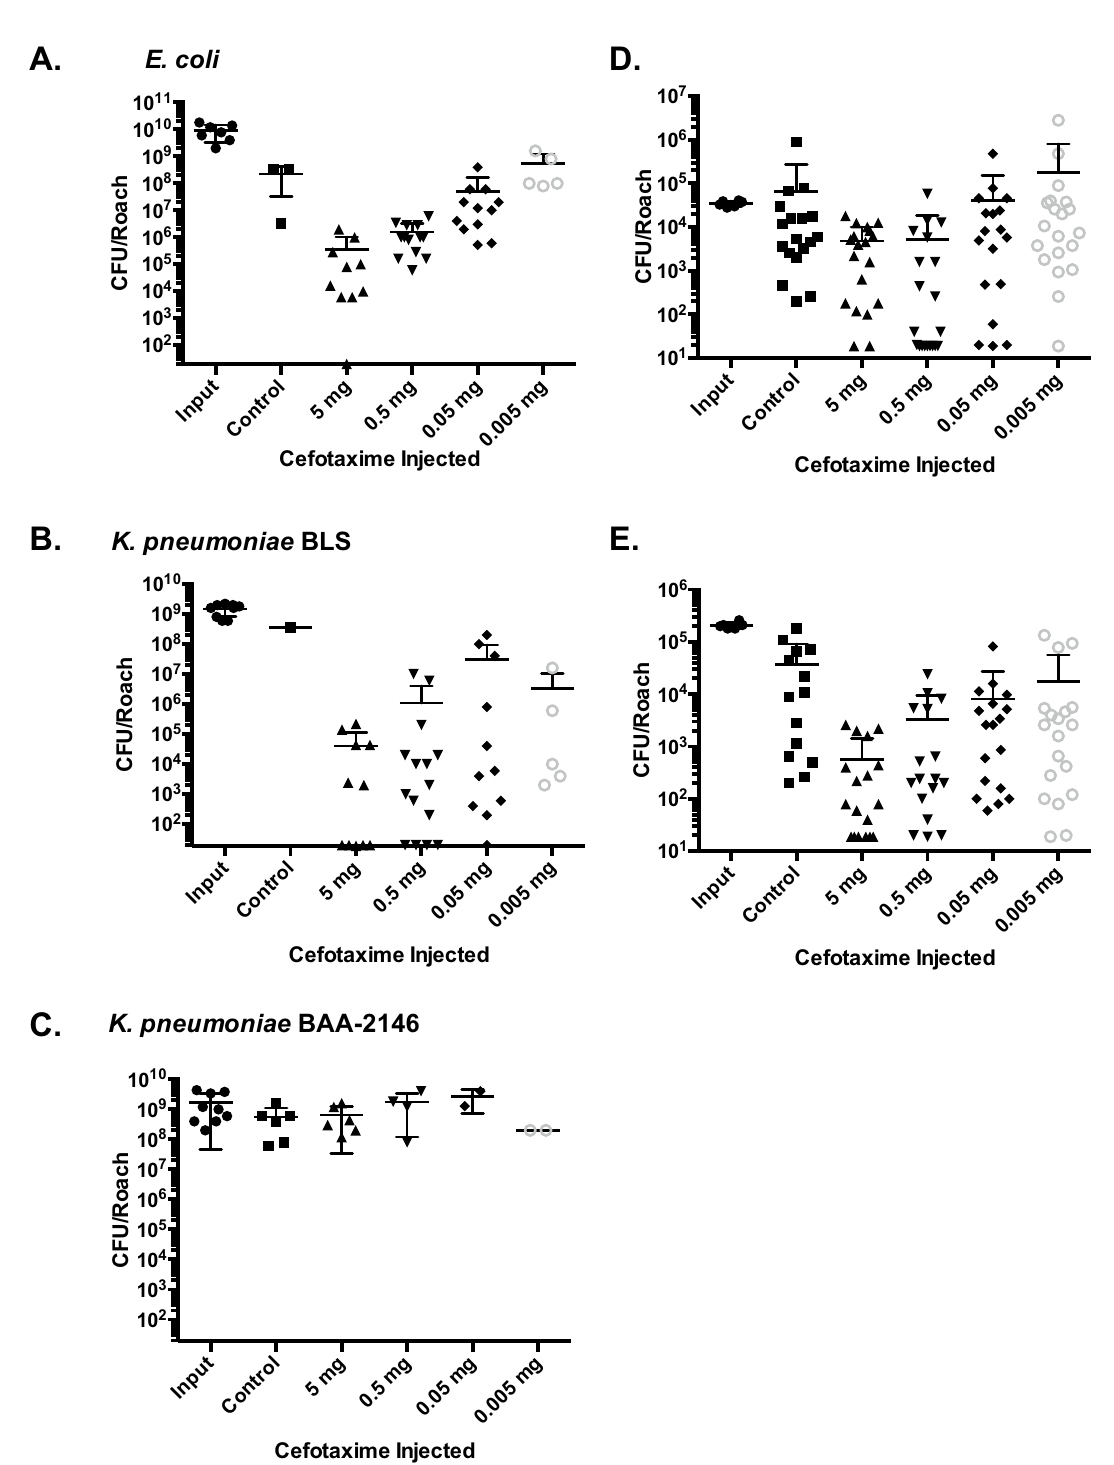
Figure 2. Treatment with cefotaxime reduces bacterial burden in a dose dependent manner that is specific to the activity of this drug. B. dubia cockroaches were infected with a lethal dose of E. coli ( A ), K. pneumoniae (BLS, Beta-lactam sensitive strain) ( B ), or K. pneumoniae (BAA-2146, Beta-lactam resistant) ( C ). Alternatively, B. dubia cockroaches were infected with a sublethal dose of E. coli ( D ) or K. pneumoniae BLS ( E ). At 24 h post infection, surviving cockroaches were euthanized and their hemolymph was isolated and mixed with an anticoagulant. This material was serially diluted and plated to enumerate CFU. CFU recovered from hemolymph was compared to input. These data were analyzed by a one way ANOVA and Tukey’s post hoc ( A , P < 0.0001; P < 0.0001for 5 mg, 0.5 mg, 0.05 mg; P = 0.0784 for 0.005 mg cefotaxime. B , P < 0.0001; P < 0.0001for 5 mg, 0.5 mg, 0.05 mg; P < 0.001 for 0.005 mg cefotaxime. C , P = 0.1676. D , P < 0.0001; P = 0.0797 for 5 mg; P = 0.0007 for 0.5 mg; P = 0.3399 for 0.05 mg; P = 0.8688 for 0.005 mg cefotaxime. E , P < 0.0001; P < 0.0001 for 5 mg, 0.5 mg; P = 0.0001 for 0.05 mg; P < 0.005 mg